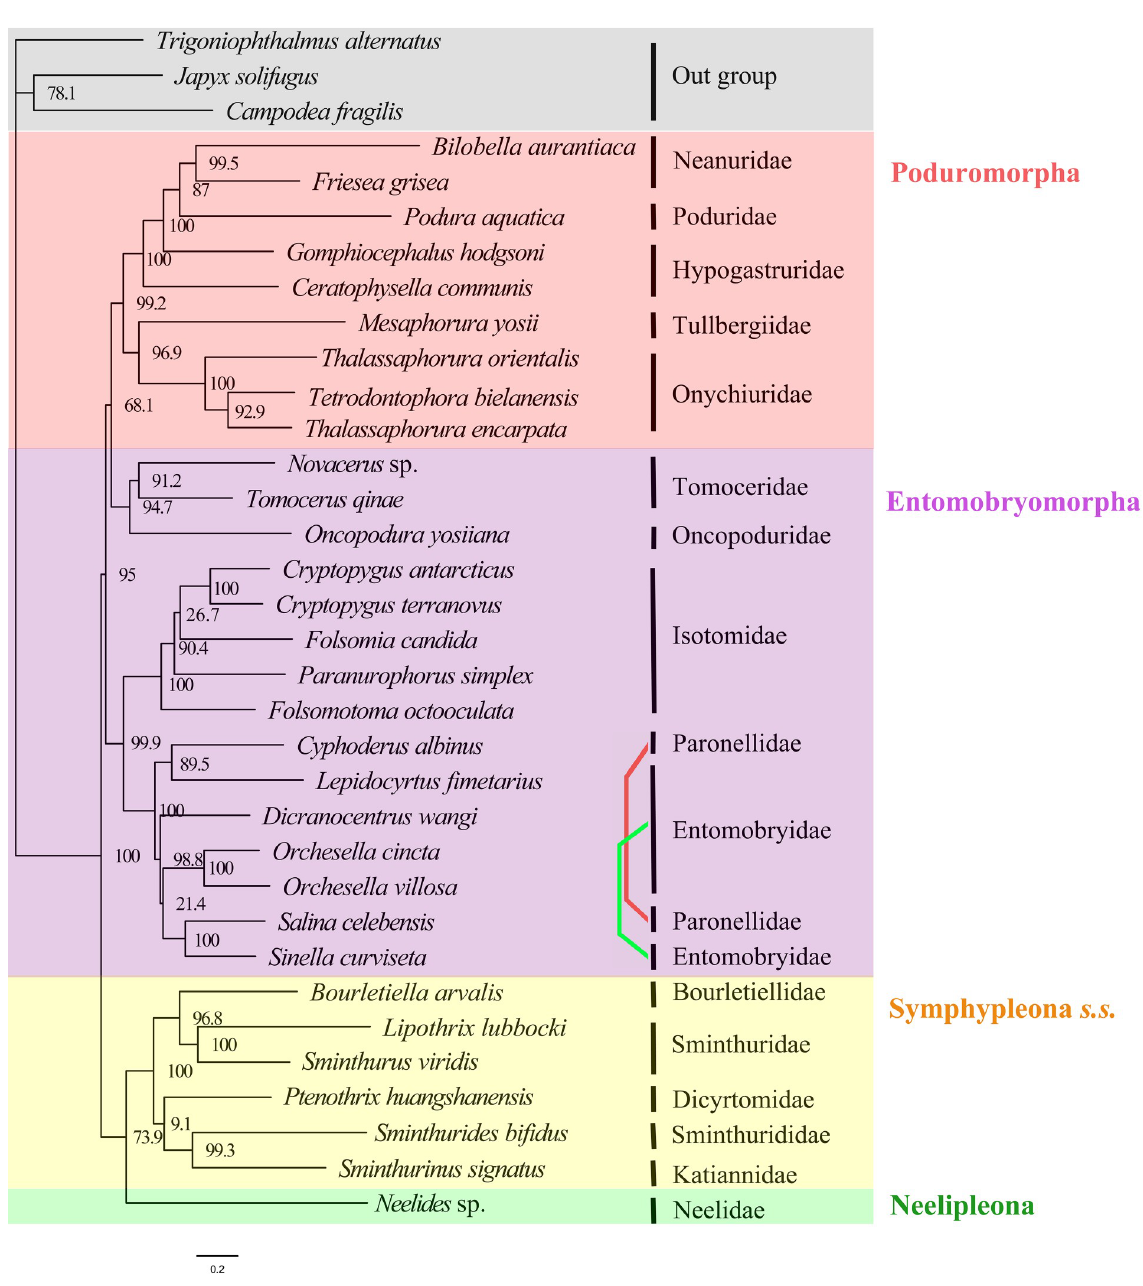
Fig 4. Maximum likelihood phylogenetic tree inferred from amino acid sequences of 13 PCGs under GHOST_mtART model (13faa_GHOST_mtART). Bootstrap support values are shown in the nodes. Each coloured line linked a same taxon in current taxonomic system separated in different